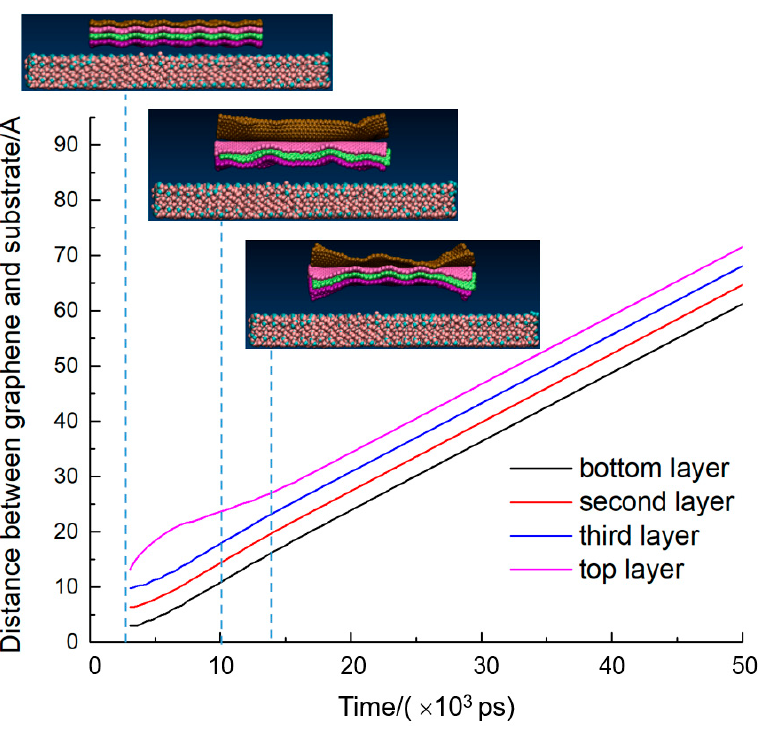
Figure 6. Exfoliation process in four-layer graphene system, when the vertical upward velocity was 10 Å/ps. The dotted blue line shows the trajectory at different points in time.